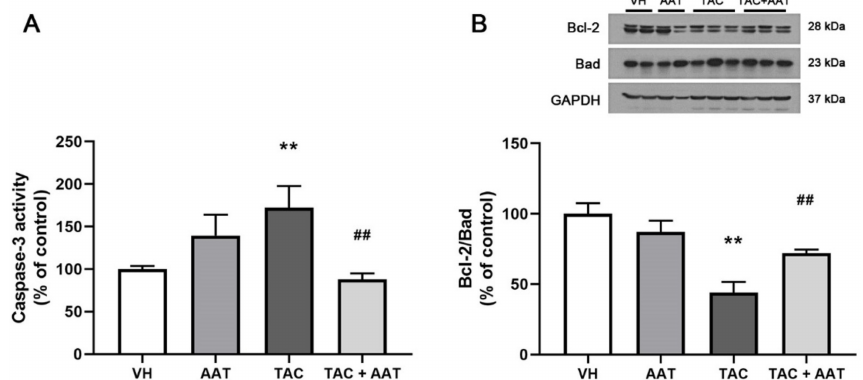
Figure 7. ( A ) E ff ect of alpha-1 antitrypsin on caspase-3 activity, and ( B ) Bcl-2 and Bad protein